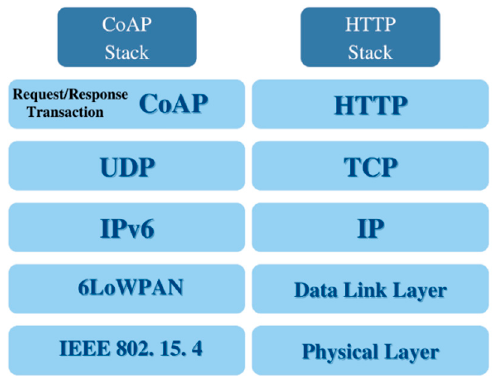
Figure 14. A CoAP stack compared to an HTTP stack.